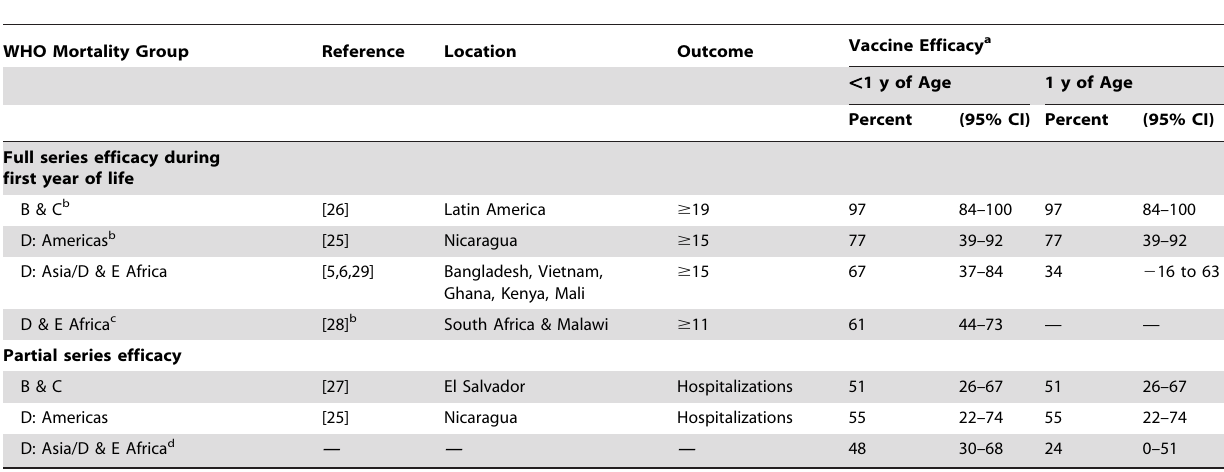
Table 2. Estimates of efficacy for partial and full series of rotavirus vaccine against the most severe reported outcome of rotavirus gastroenteritis, by WHO mortality